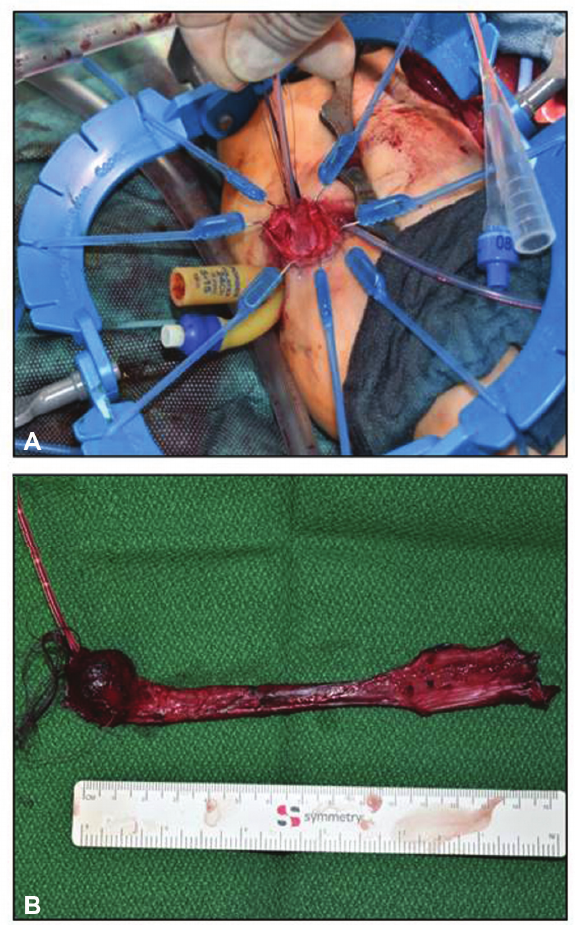
Fig. 5 ( A and B) Mucosectomy (Soave plane) of the rectal duplication leading to the perineal fi stula leaving its muscular cuff in place.